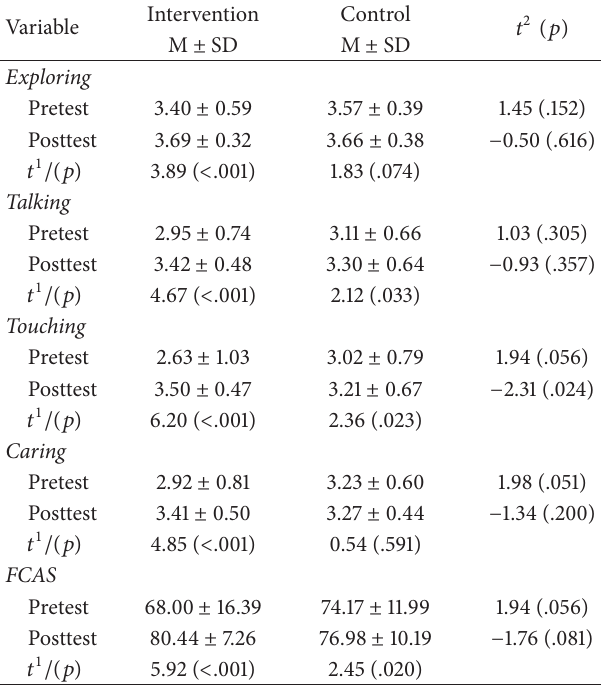
Table 2: Pretest and posttest FCAS scores and score changes ( 𝑁 = 83 ).